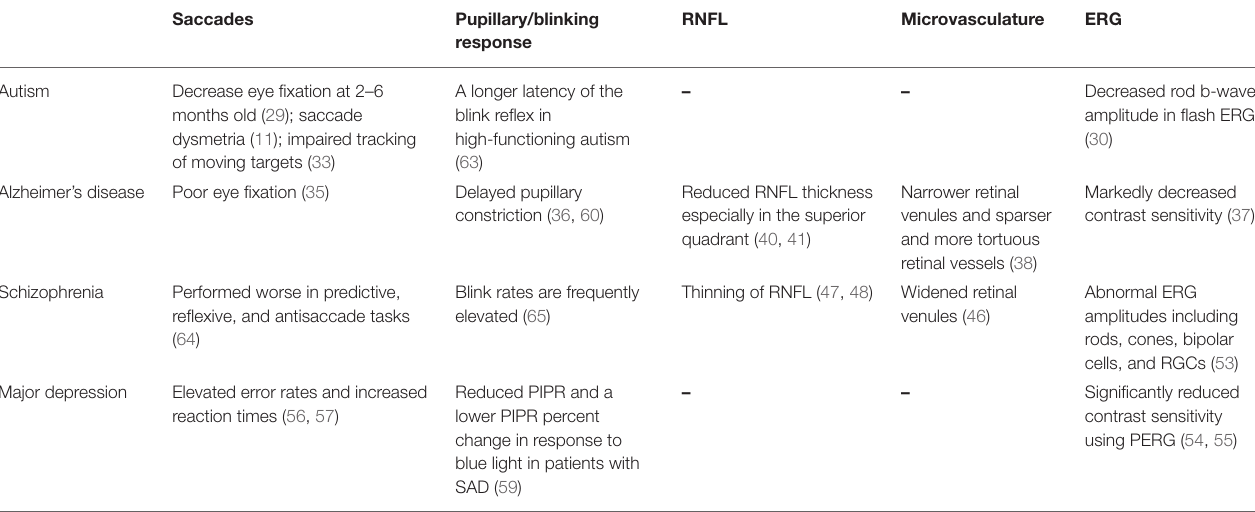
TABLE 1 | Multiple changes in ocular parameters via ophthalmological assessments are associated with neurological